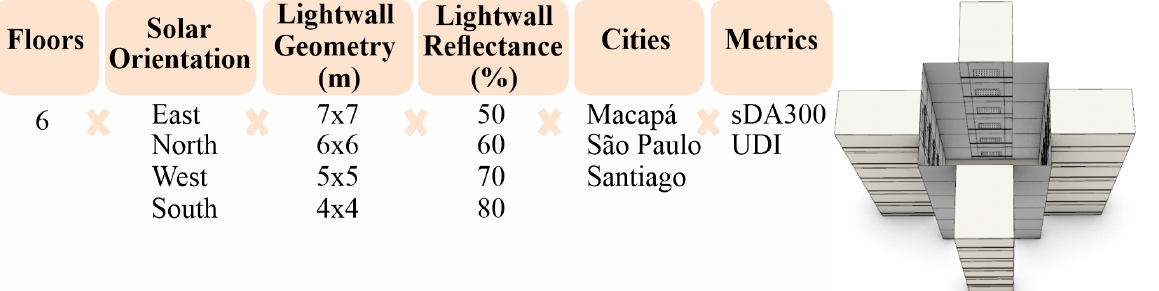
Figure 1. Simulated model